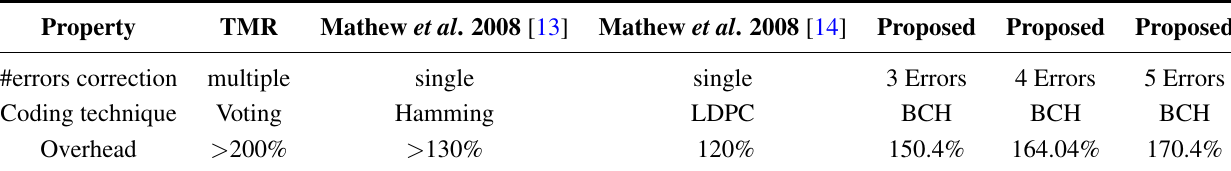
Table 1. Comparison with Other Approaches for 45-bit